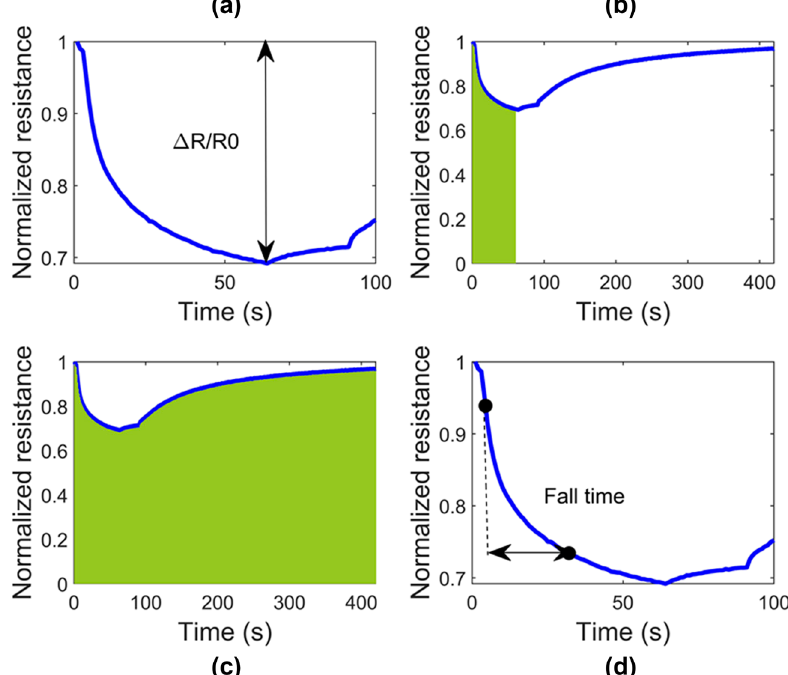
Figure 12: Four features extracted from the normalized signal of nanowire SnO 2 sensor: ( a ) variation of resistance from the baseline ( DR/ R 0 ) ; ( b ) area under the signal up to the minimum ( in green ) ; ( c ) total area under the signal ( in green ) ; and ( d ) fall time between 10 and 90% of the signal drop. Reprinted with permission from ref. [ 74 ]